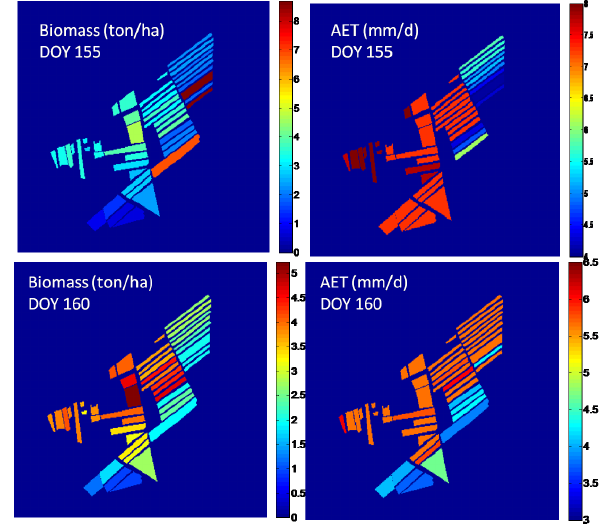
Figure 8. The biomass and evapotranspiration simulated by STICS on 9 June 2006 (DOY160) Fig. 8. The biomass and evapotranspiration simulated by STICS on Fig. 8. The biomass and evapotranspiration simulated by STICS on 4 and 9 June 2006 (DOY 155 160). 4 and 9 June 2006 (DOY 155